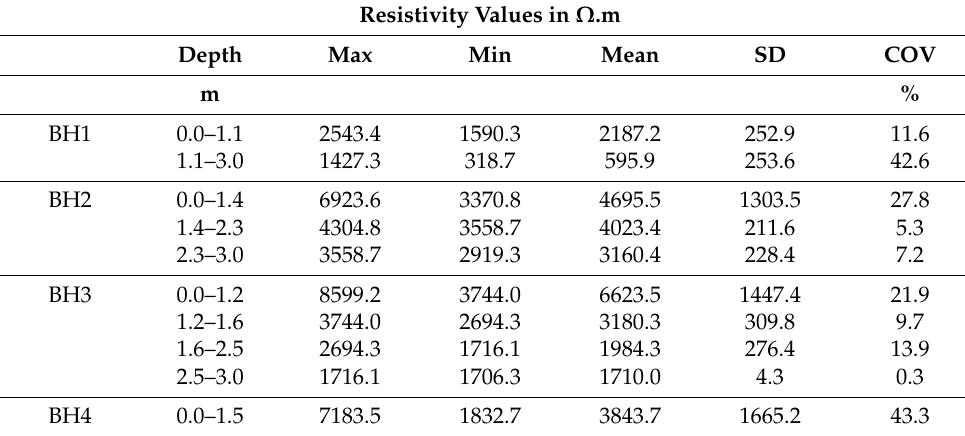
Table 5. Resistivity results from the ERT study.